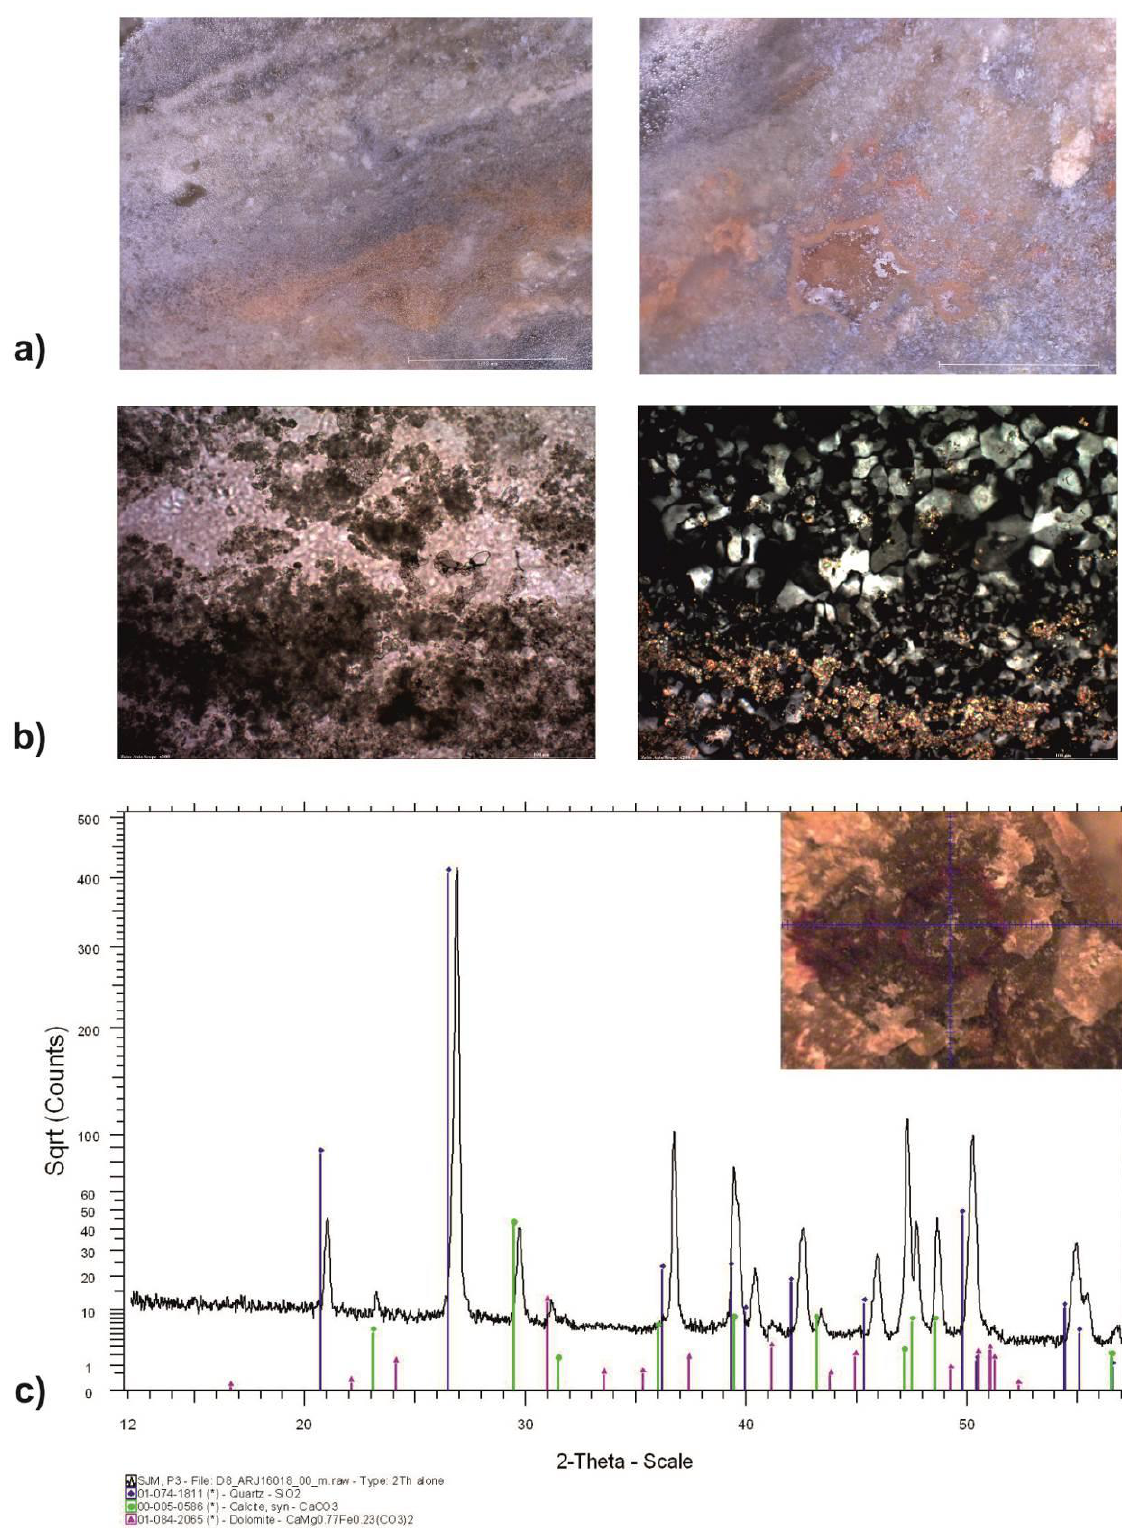
Figure 5. a) Macroscopic appearance of Thanetian cherts with lamination and presence of ferric oxides b) Thin section images (left: plane polariser) showing a high presence of carbonates and isometric microquartz and megaquartz (right:crossed polariser). c) μ-XRD of the indicated